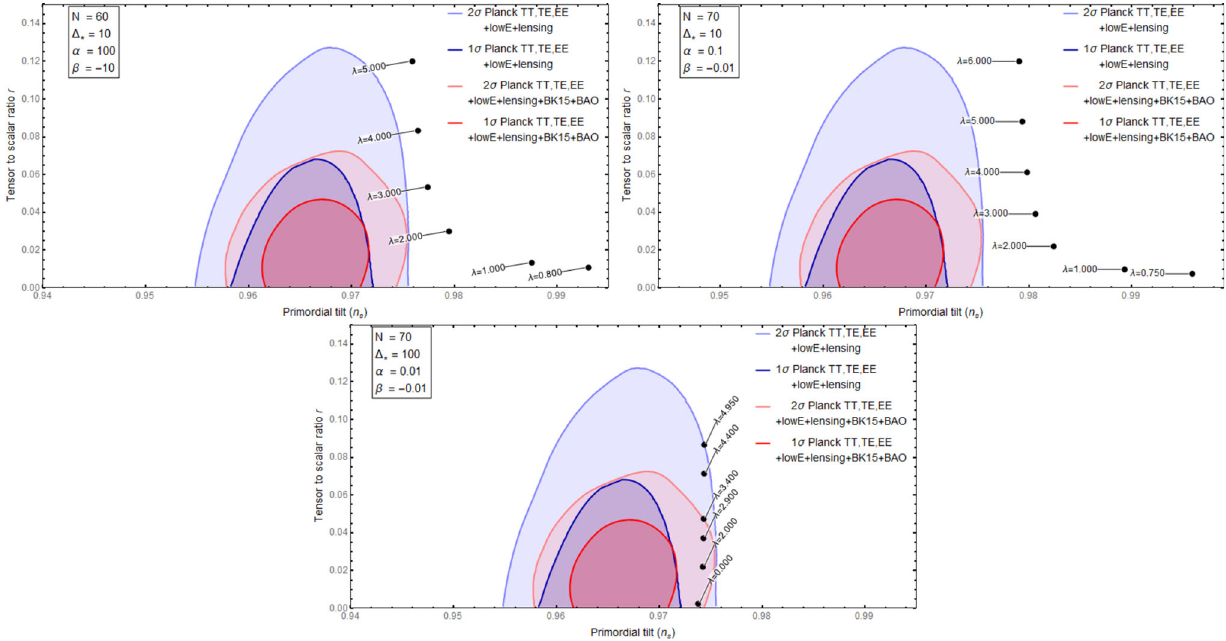
Fig. 5 We compare the theoretical predictions in the ( r − n s ) plane for different values of λ using (cid:23) (cid:25) = 10 , α = 100 , β = − 10 . 0 , N = 60 (upper-left panel); (cid:23) (cid:25) = 10 , α = 0 . 1 , β = − 0 . 01 , N = 70 (upper- right panel); (cid:23) (cid:25) = 10 , α = 0 . 1 , β = − 0 . 01 , N = 60 (lower